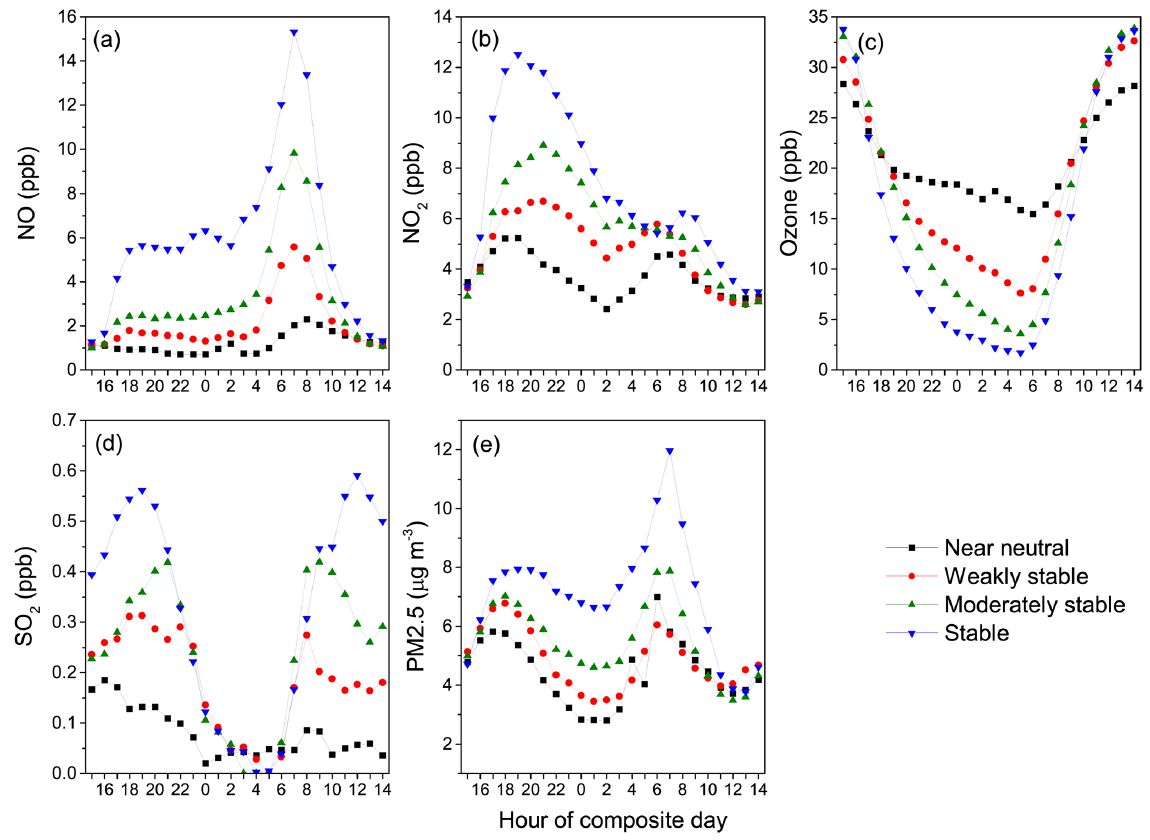
Figure 9. Mean hourly diurnal composites of (a) NO, (b) NO 2 , (c) Ozone, (d) SO 2 , and (e) PM 2 . 5 , for each of the four radon-derived atmospheric stability classifications.